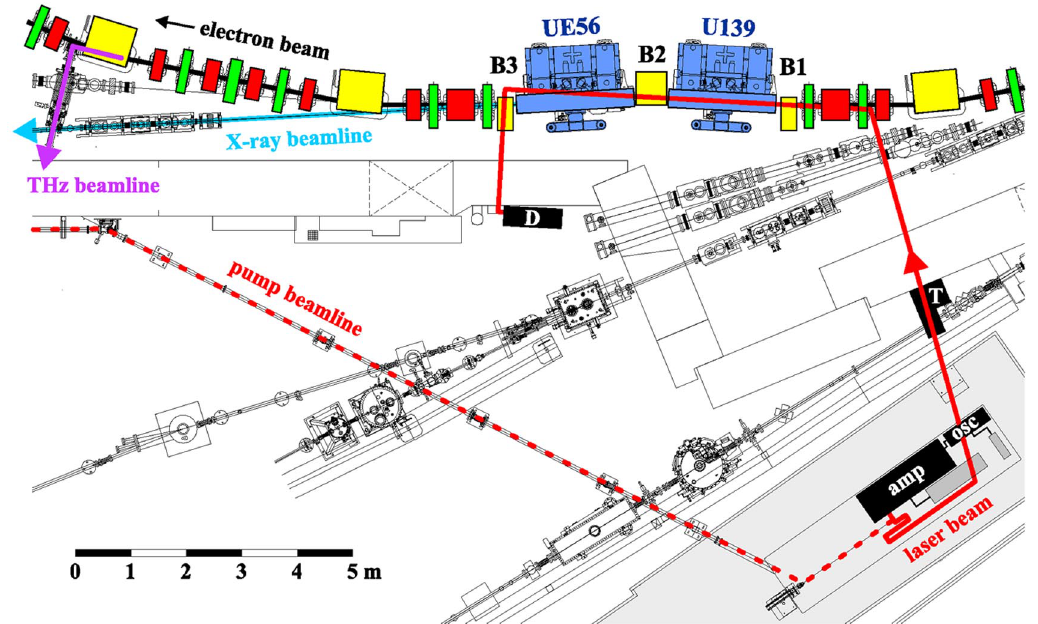
FIG. 1. (Color) BESSY II floor plan showing a part of the electron storage ring with dipole (yellow), quadrupole (red), and sextupole magnets (green). A closed orbit bump (B1-B2-B3) encloses the modulator (U139) and the radiator (UE56). A hutch (gray) outside the ring tunnel contains a Ti:sapphire oscillator (osc) and amplifier (amp). The laser beam (solid red line) is focused by a telescope (T) and ends at a diagnostics station (D), while pump pulses (dotted red line) are directed to the experiment at the end of the x-ray beam line (blue). The energy modulation is monitored using THz radiation